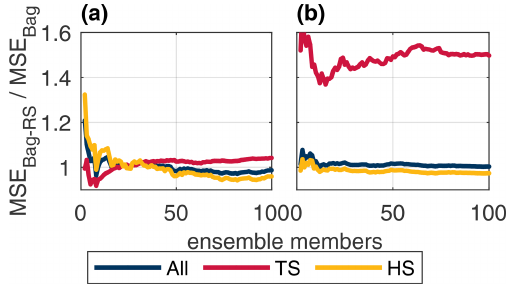
Figure 12. Test MSE ratio between the bagging and SMOTER- Bagging models for the Bow (a) and Don (b) rivers across ensemble